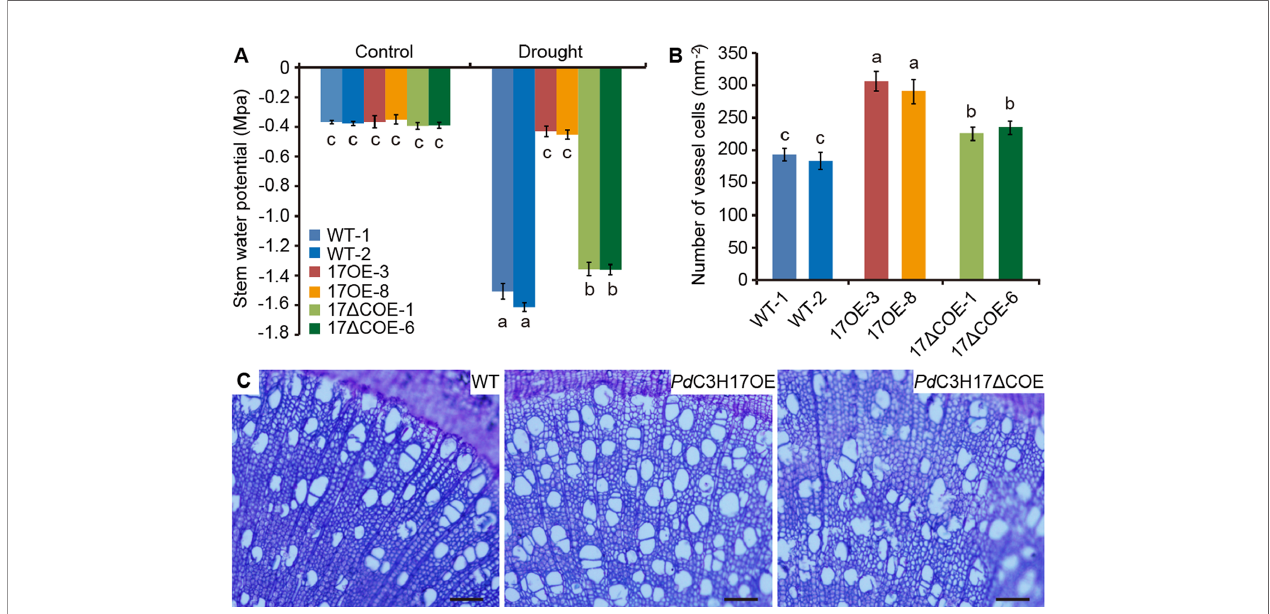
FIGURE 3 | Stem water potential and xylem vessel cell numbers of WT, Pd C3H17OE, and Pd C3H17 D COE poplars. (A) Statistical analysis of stem water potential of 4-month-old WT, Pd C3H17OE (17OE), and Pd C3H17 D COE (17 D COE) poplars under well-watered and drought stress conditions for 20 days. (B) Statistical analysis of the numbers of stem xylem vessel cells in 3-month-old WT, 17OE, and 17 D COE poplars. At least six plants from two lines in each genotype were selected for measurement of stem water potential and xylem vessel cells. Data are presented as mean ± SD. Different letters above bars denote statistical signi fi cance between treatments of samples ( P < 0.05). (C) Basal stem sections of 3-month-old representative WT, Pd C3H17OE, and Pd C3H17 D COE plants. Bars = 100 m m.